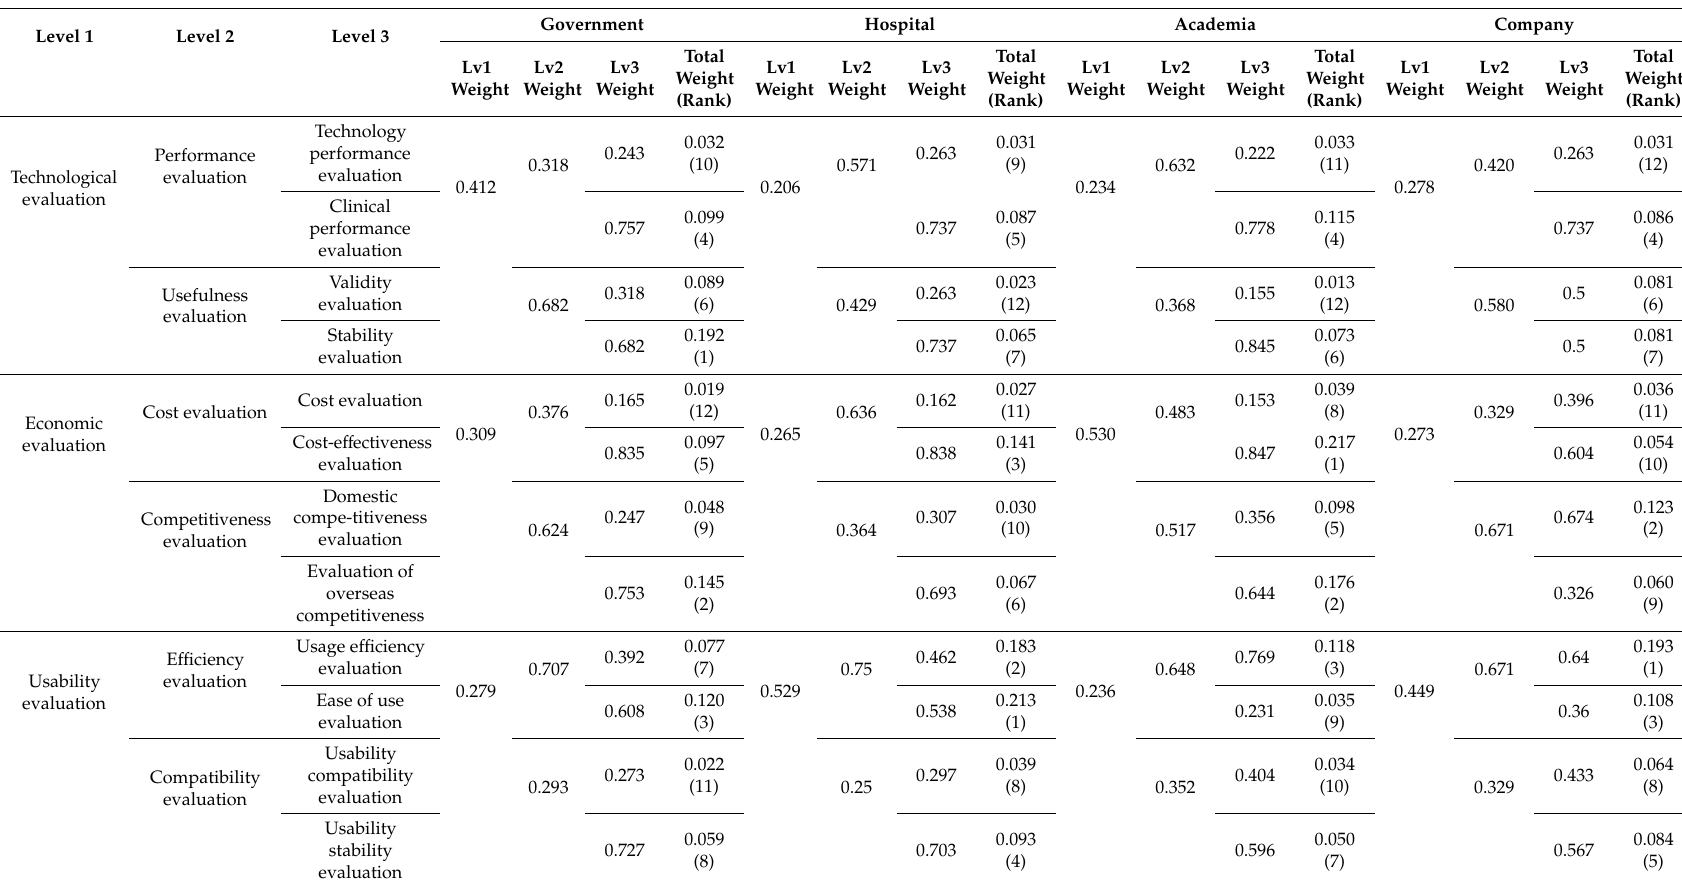
Table 6. Evaluation indicators and rankings by stakeholders in evaluation framework for optimal medical device